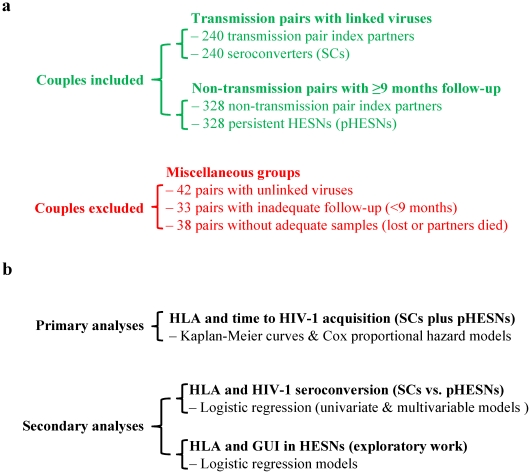
Selection of Zambian subjects for this study (Panel a) and summary of statistical strategies (Panel b).In all, 568 couples (240 transmission pairs and 328 non-transmission pairs) were eligible (see Table 1). Non-genetic factors included age of HESN, sex, direction of transmission (M to F or F to M), genital ulcer/inflammation (GUI), and viral load (VL).